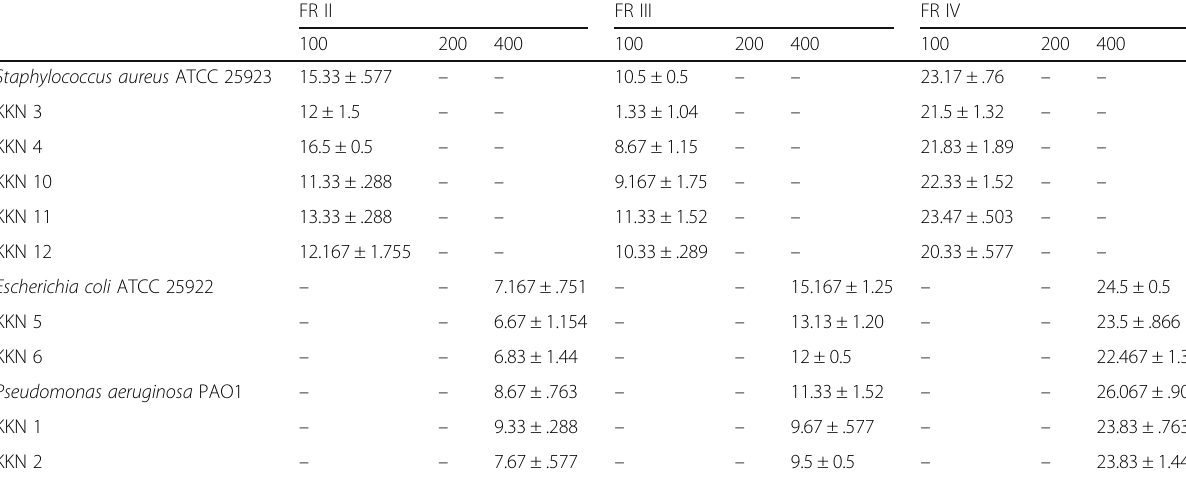
Table 4 Diameters of inhibition zones (mm) of fractions from C. gigantea ethyl acetate